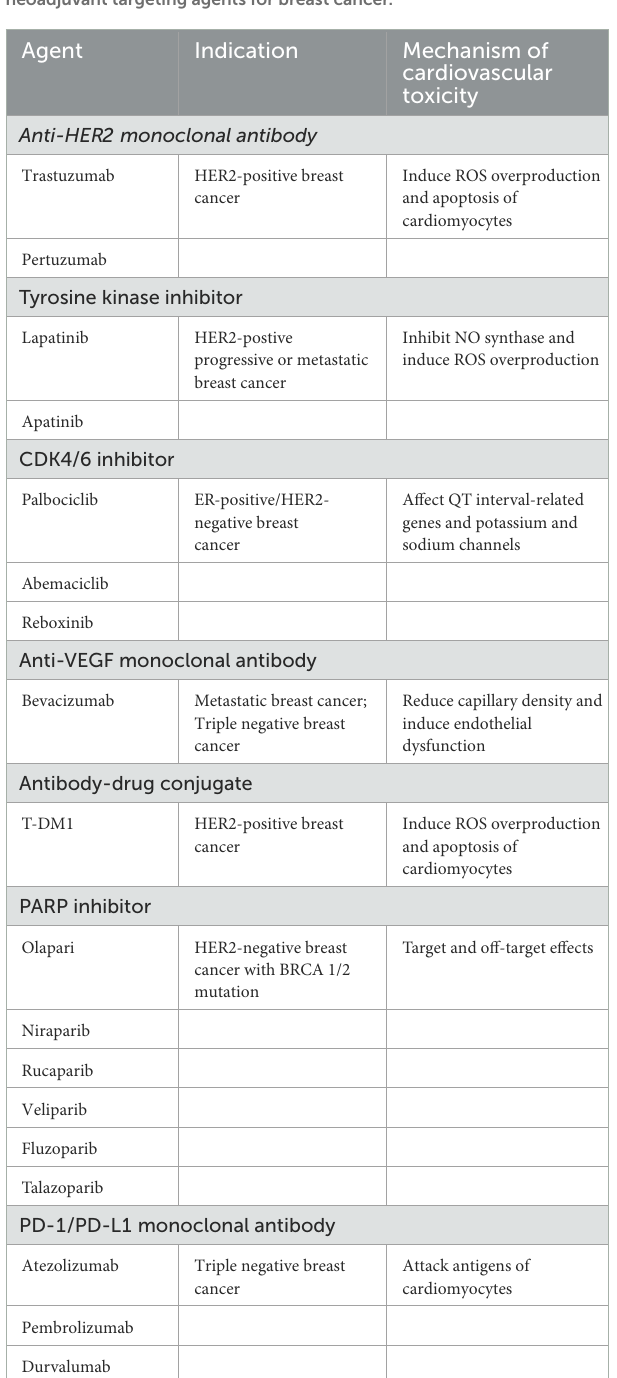
TABLE 1 Mechanisms of cardiovascular toxicity associated with neoadjuvant targeting agents for breast